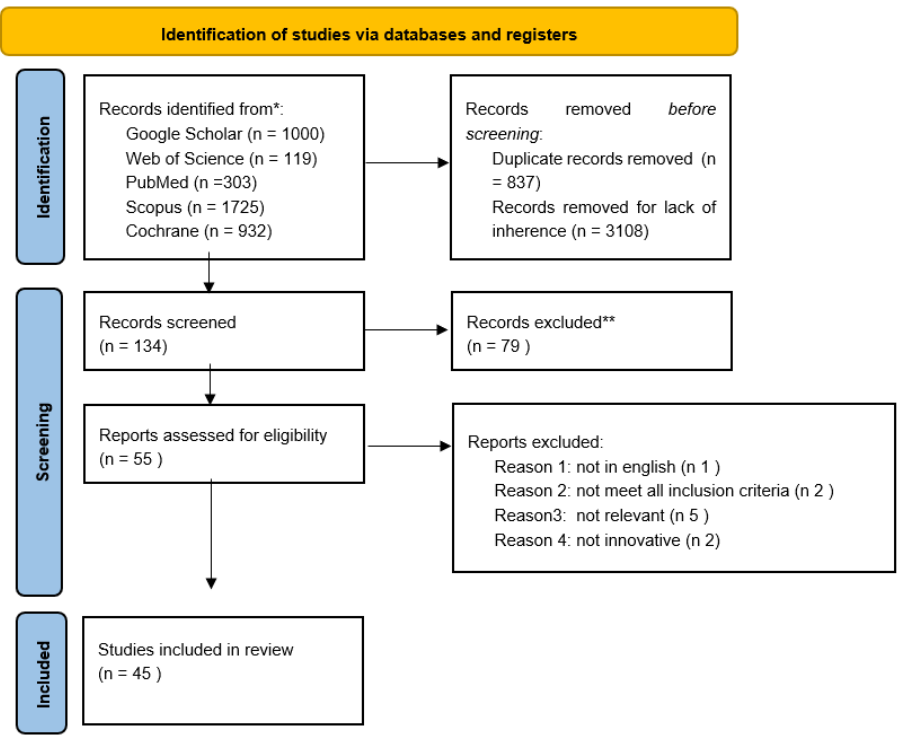
Figure 2. Flow chart of all the harvested papers.